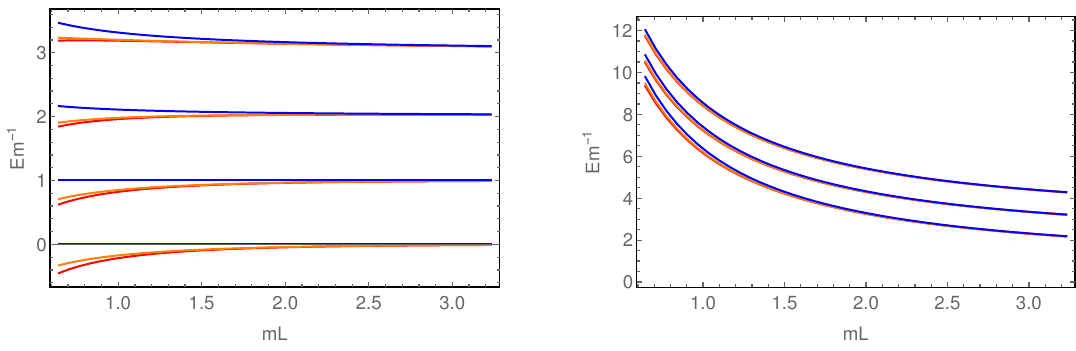
Figure 3 . Theoretical low-lying energy spectrum of sinh-Gordon model at b = 1. The vacuum energy density is subtracted. Left: states in the sector of overall momentum 0 (from the bottom up: j vac i , j 0 i ; j 00 i and j 000 i ). Right: states of overall momentum 1 (cid:1) 2 (cid:25)L (cid:0) 1 (from the bottom up: j 1 i , j 01 i and j 001 i ). Note that we label the states by the corresponding bosonic Bethe Ansatz quantization numbers. Bethe-Yang lines are drawn with blue curves. The leading L(cid:127)uscher correction is depicted by orange curves. The exact TBA result is shown with red